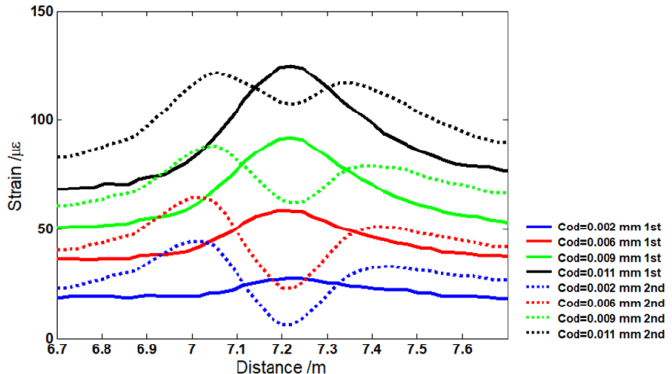
Figure 6. Comparison of first-time and second-time measurement strains in crack region.